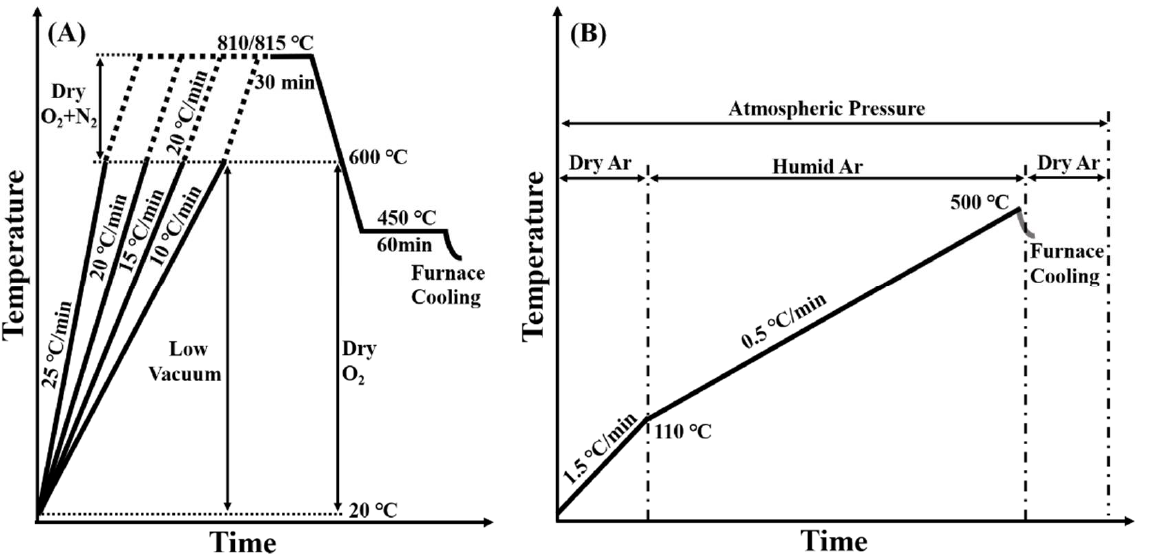
Figure 2. ( A ) Heating profile of low-vacuum pyrolysis YBCO film, ( B ) conventional film by FF- MOD.